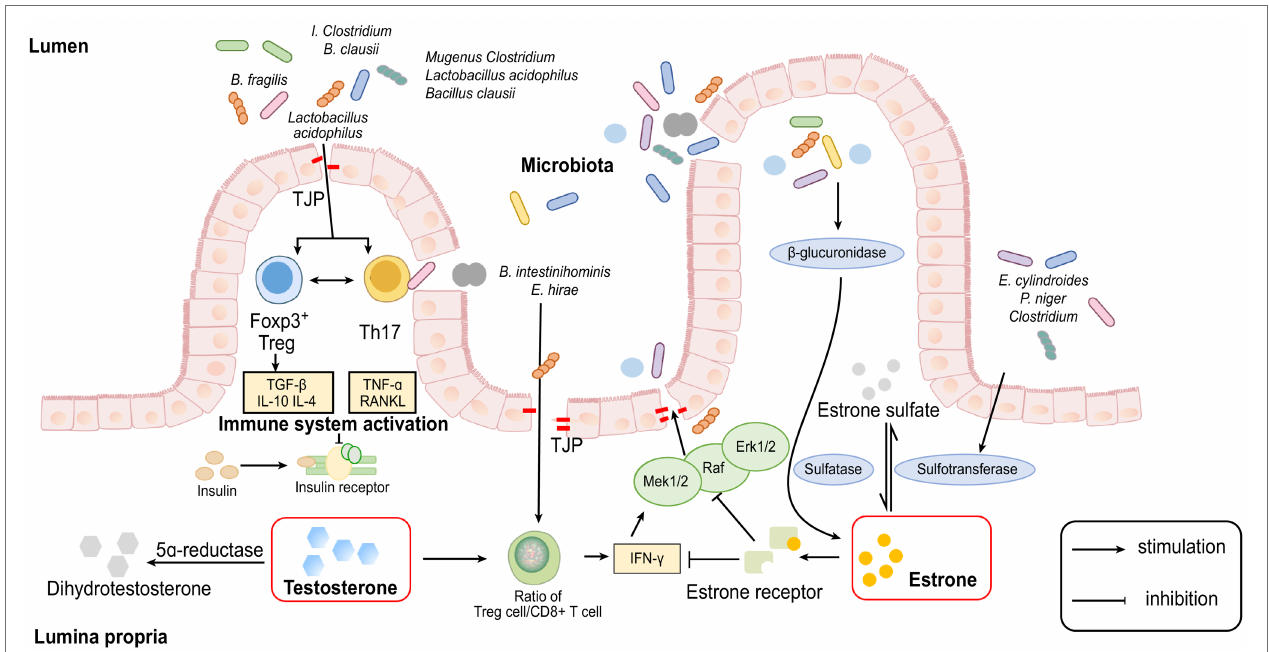
FIGURE 1 | Cellular and molecular mechanisms involved in the interaction between sex hormones and gut